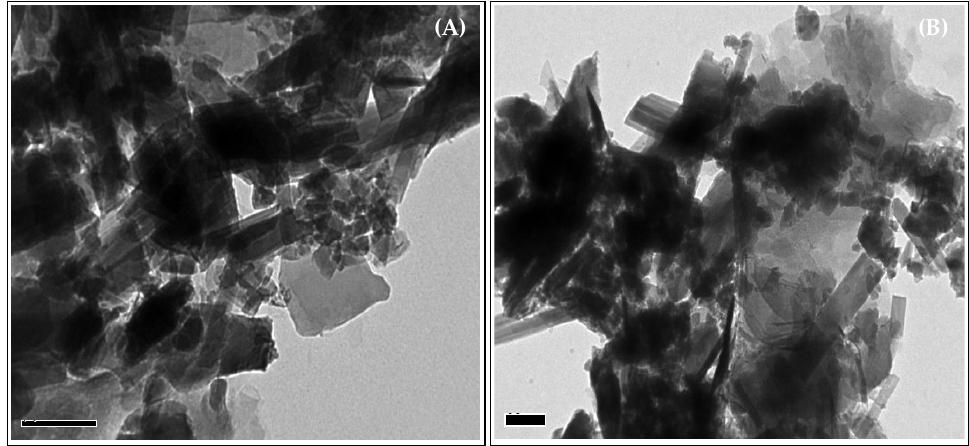
Figure 7. TEM images of ( A ) natural zeolite; ( B ) acidic transformed natural zeolite.